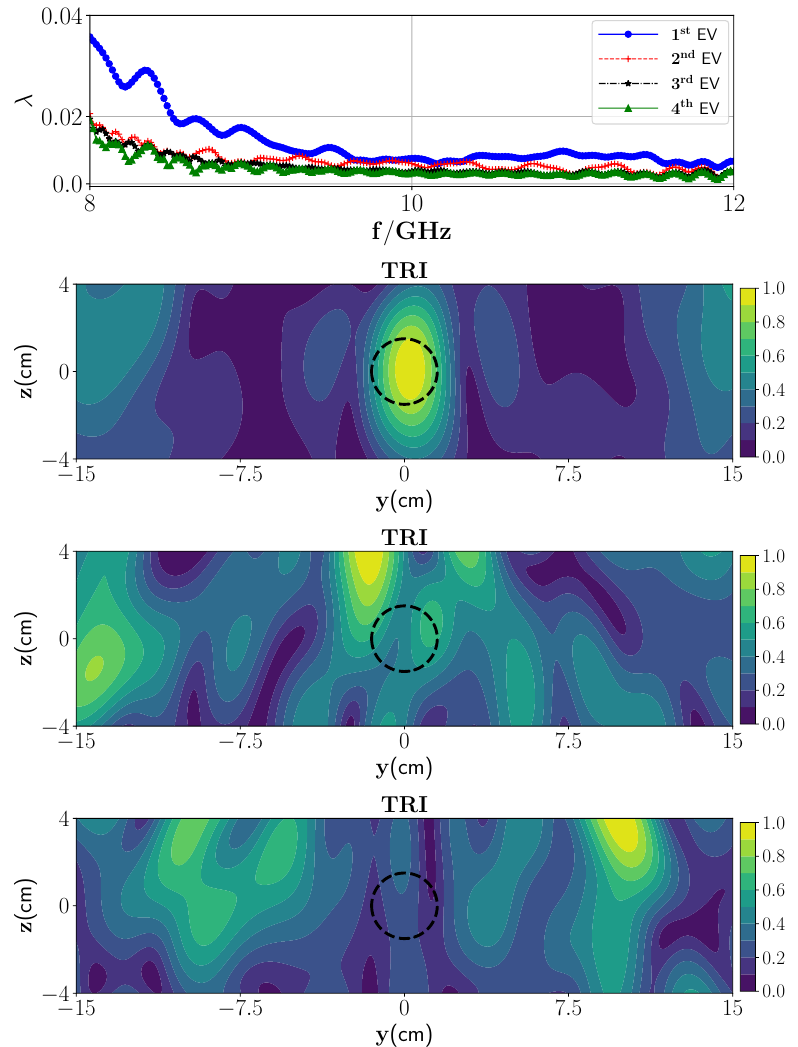
Figure 5. ( Top ) Magnitude of the first four eigenvalues versus the frequencies and ( second row ) reconstruction of one wet spot moisture case with TRI-DORT where the true location is marked by black dashed lines, ( third row ) reconstruction using third eigenvalue and its associated eigenvector, ( fourth row ) reconstruction using fourth eigenvalue and its associated